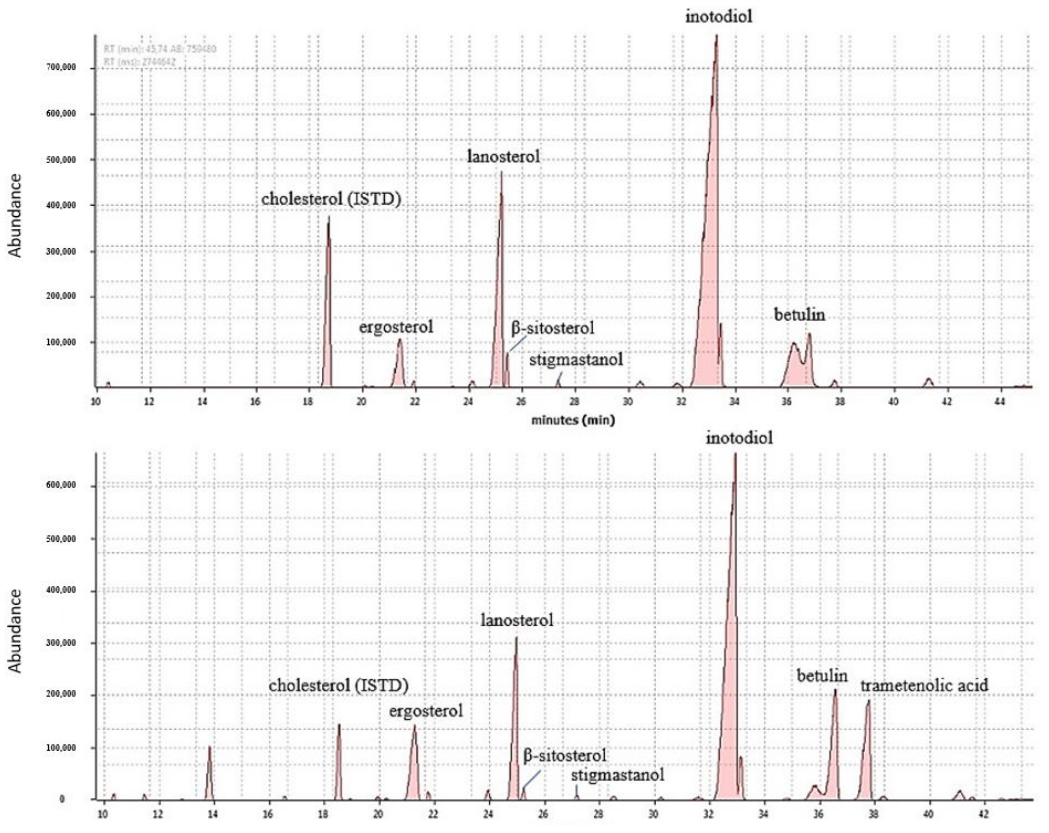
Figure 1. Comparison between chromatograms of GC-MS (total ion chromatogram) obtained by SFE (upper) and Folch method (lower).